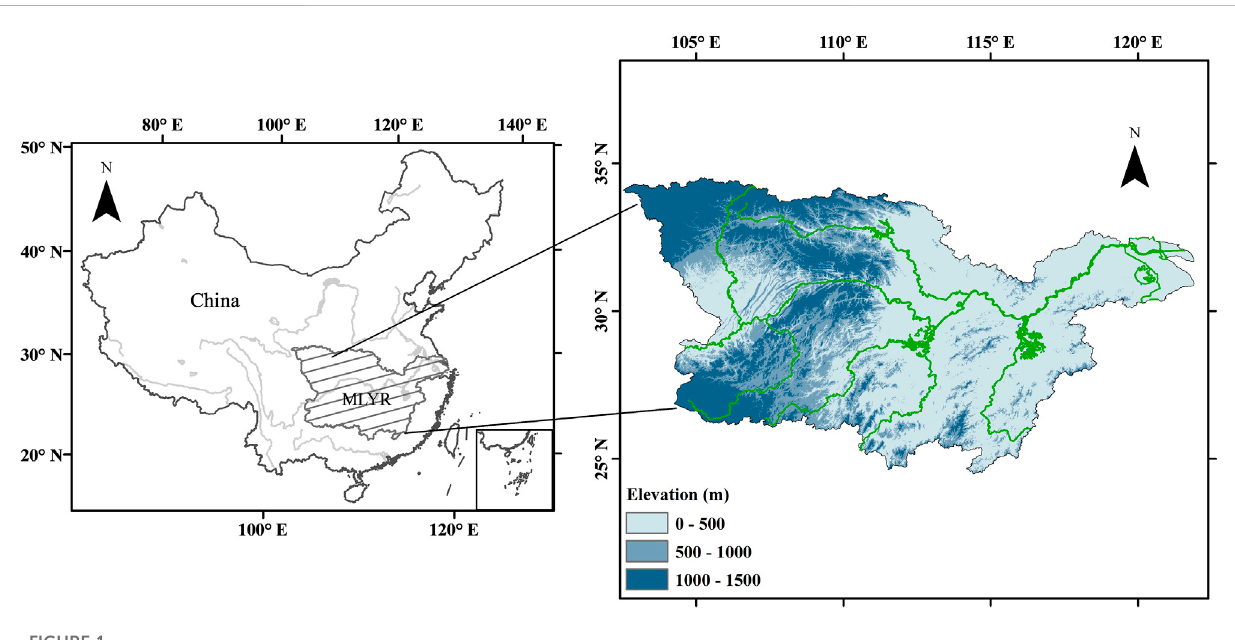
FIGURE 1 The MLYR domain and topography